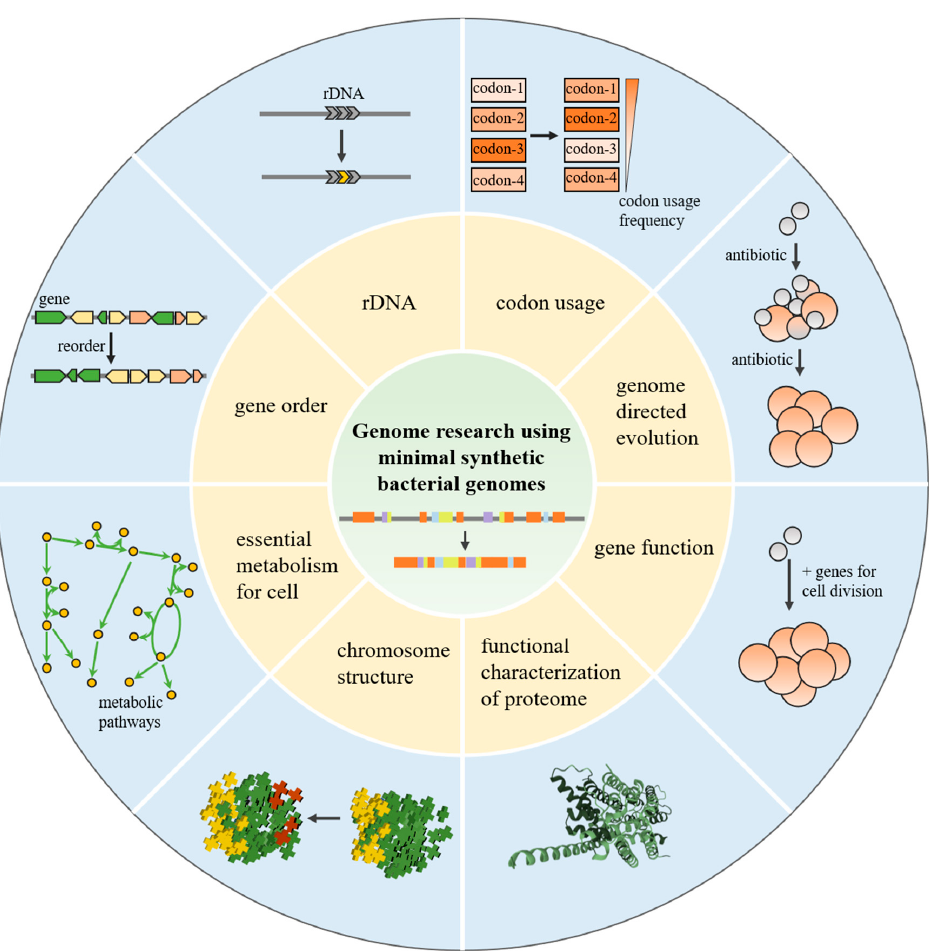
Figure 2. Genome research using minimal synthetic bacterial genomes. Part of the genome was rewritten to explore genome plasticity. Strains can evolve rapidly in an antibiotic environment. Genes for cell division were discovered. A comprehensive cell model was depicted.